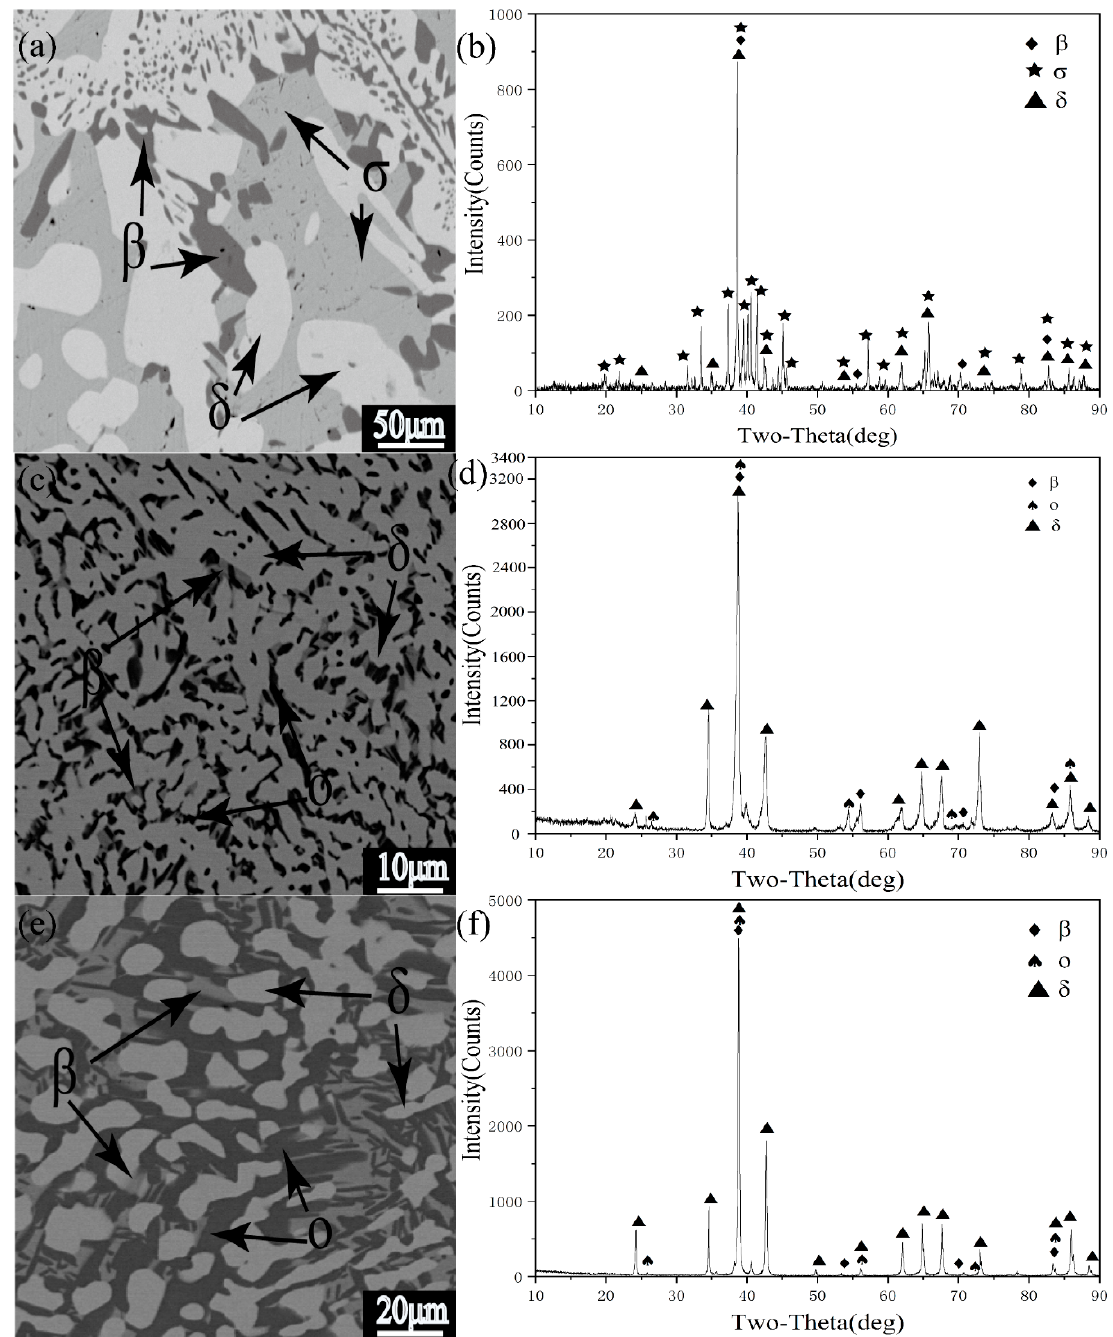
Figure 6. EPMA images and XRD results of alloy #8 after annealing at 1000 °C, 900 °C, 800 °C. ( a ) The microstructure of alloy #8 at 1000 °C; ( b ) the XRD result of alloy #8 at 1000 °C. ( c ) The microstructure of alloy #8 at 900 °C; ( d ) the XRD result of alloy #8 at 900 °C. ( e ) The microstructure of alloy #8 at 800 °C; ( f ) the XRD result of alloy #8 at 800 °C.